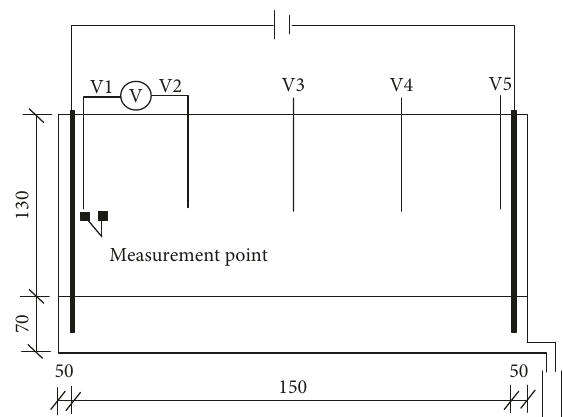
Figure 1: Schematic diagram of the model test device (units: